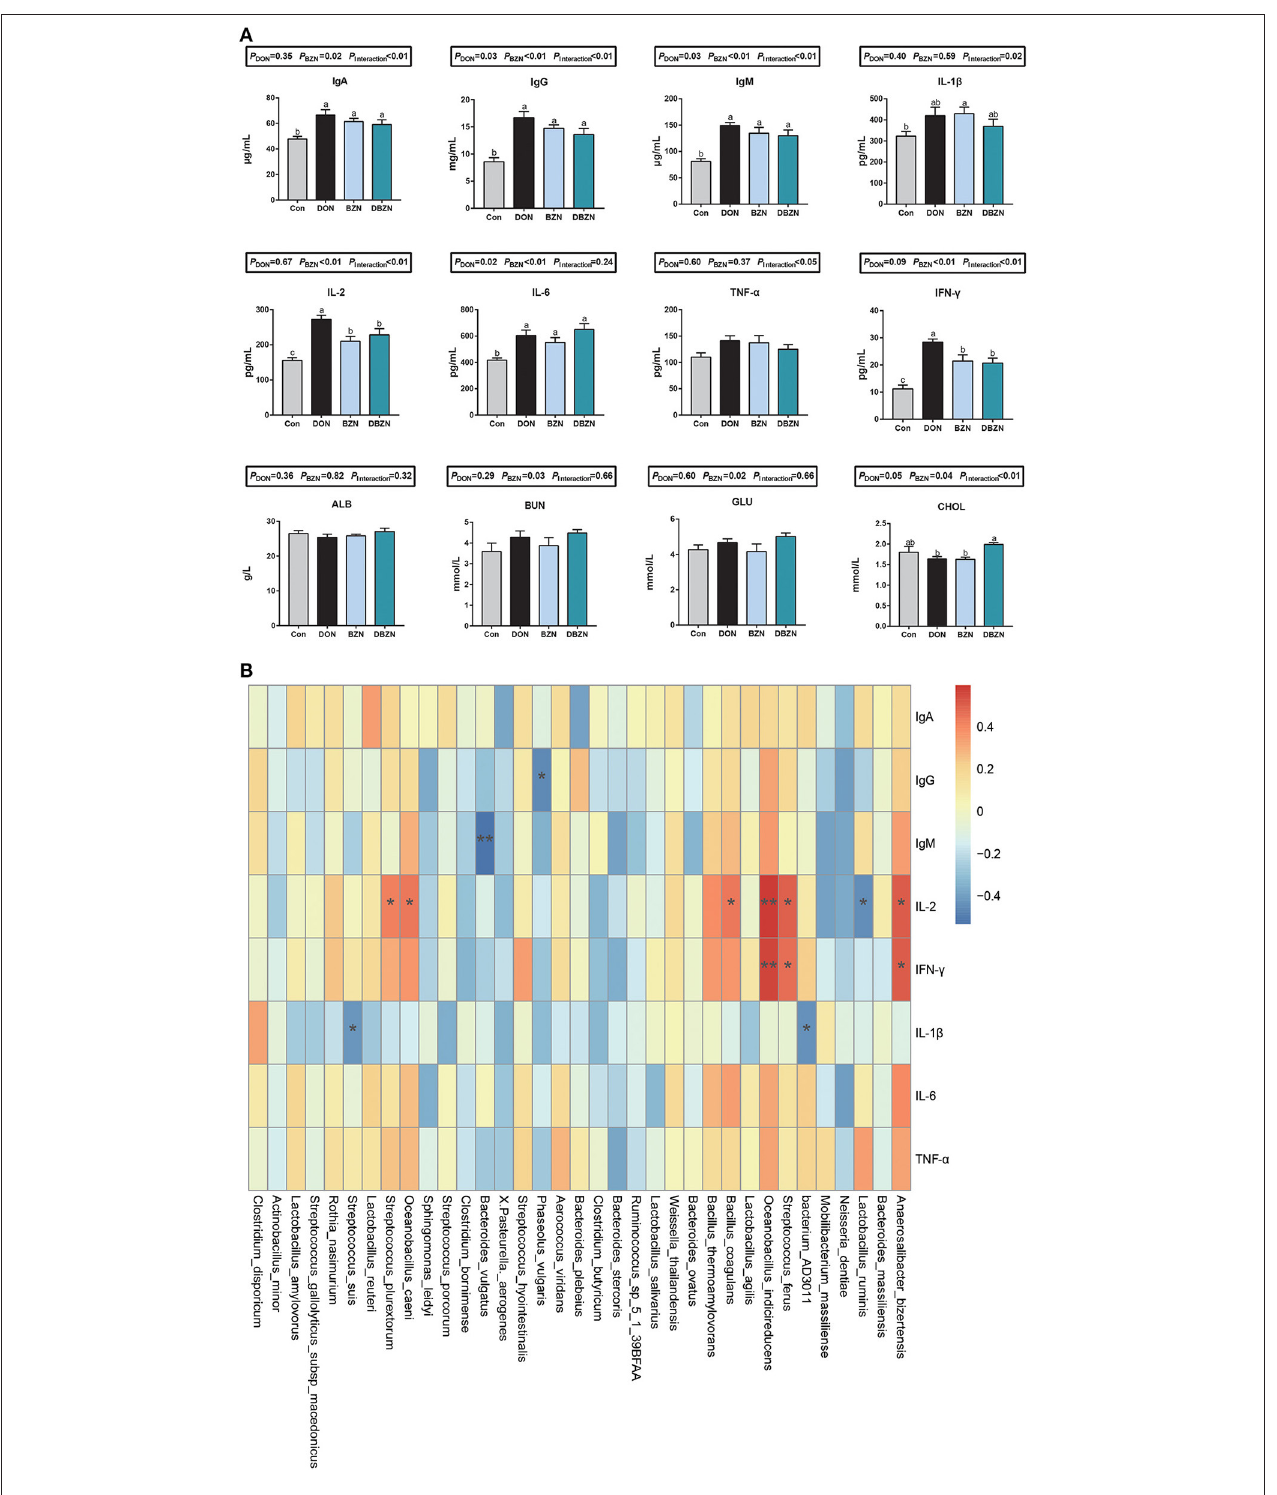
FIGURE 4 | BZN- and DON-mediated inflammatory responses and correlations with intestinal microbiome. (A) Serum inflammatory indices. ab Different letters mean significantly difference. (B) The Spearman correlations between the intestinal microbiome and serum inflammatory indices. * p < 0.05, ** p < 0.01. Dietary treatment: Con, basal diet; DON, 4 mg/kg DON-contaminated diet; BZN, 0.5% BZN supplementation diet; DBZN, 0.5% BZN supplement in 4 mg/kg DON-contaminated diet. IL-1 β , interleukin-1 β ; IgG, immunoglobulin G; IFN- γ , interferon-gamma γ ; IL-6, interleukin-6; IgA, immunoglobulin A; GLU, glucose; IgM, immunoglobulin M; CHOL, total cholesterol; IL-2, interleukin-2; TNF- α , tumor necrosis factor- α ; ALB, albumin; BUN, blood urea nitrogen; BZN, baicalin–zinc complex; Con, control; DON, deoxynivalenol.